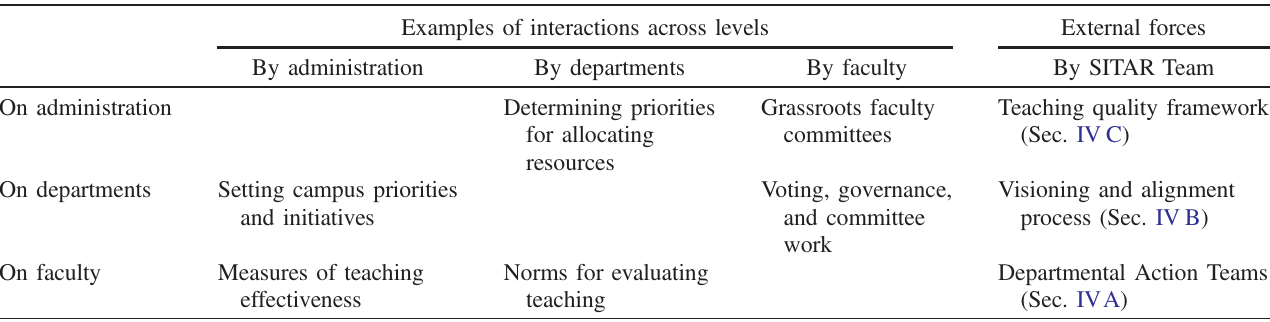
TABLE I. Examples of interactions among the levels of the university (column label denotes level doing the acting and row label denotes level being acted on) and the change activities that our project engages in at each level. Examples of interactions across levels By